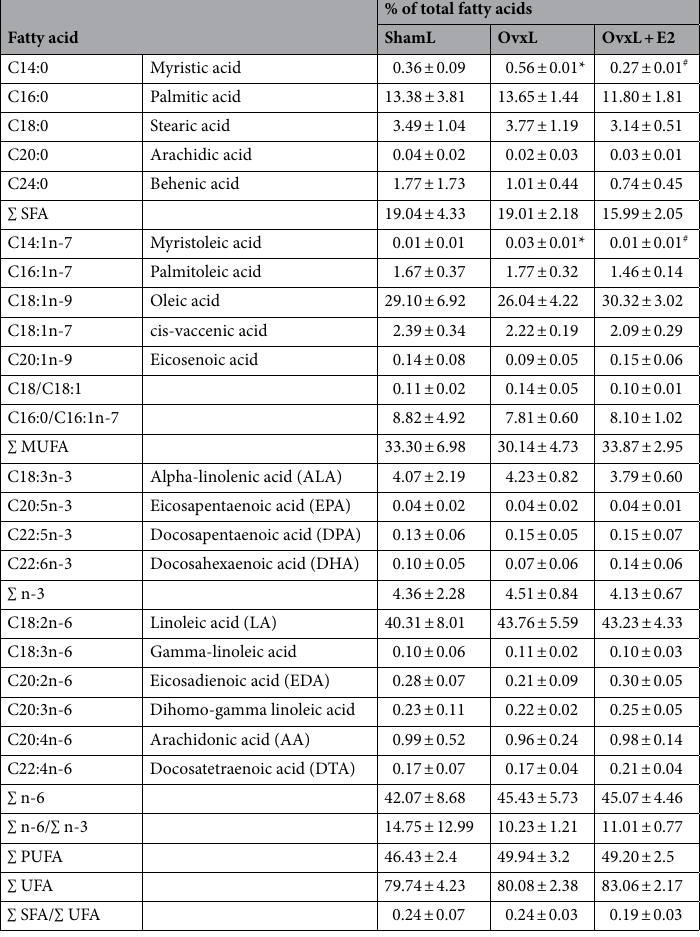
Table 4. Fatty acid profile of RET cholesteryl ester lipids obtained from ovariectomized (Ovx) or Sham operated rats, fed a lard-enriched (L) diet, subjected or not to oestrogen replacement therapy (E2). Data presented as means ± standard error (SE) of the % of total FAs. n = 6 for each group. SFA saturated fatty acids, MUFA monounsaturated fatty acids, PUFA polyunsaturated fatty acids. *p < 0.05 vs ShamL; #p < 0.05 OvxL vs OvxL +